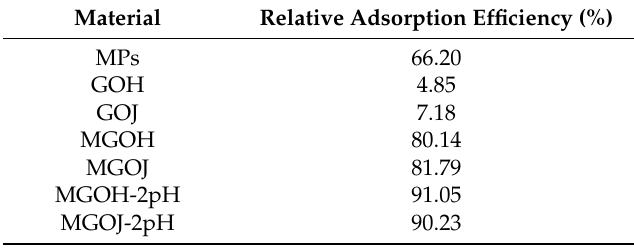
Table 2. The relative values of the adsorption efficiency from a solution with Se(IV) concentration of 5 μ g/mL for MPs, GOH, GOJ, MGOH, MGOJ, MGOH-2pH, and MGOJ-2pH.